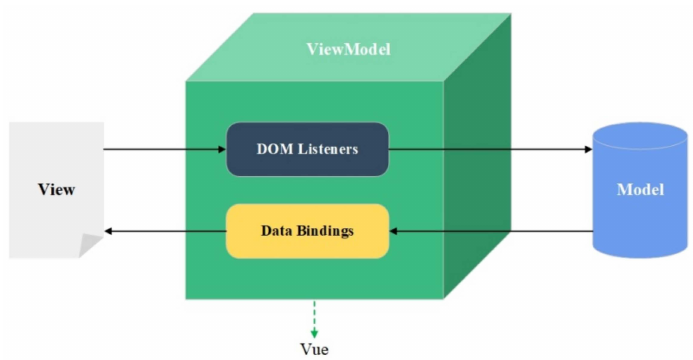
Figure 5. Schematic diagram of MVVM mode of Vue